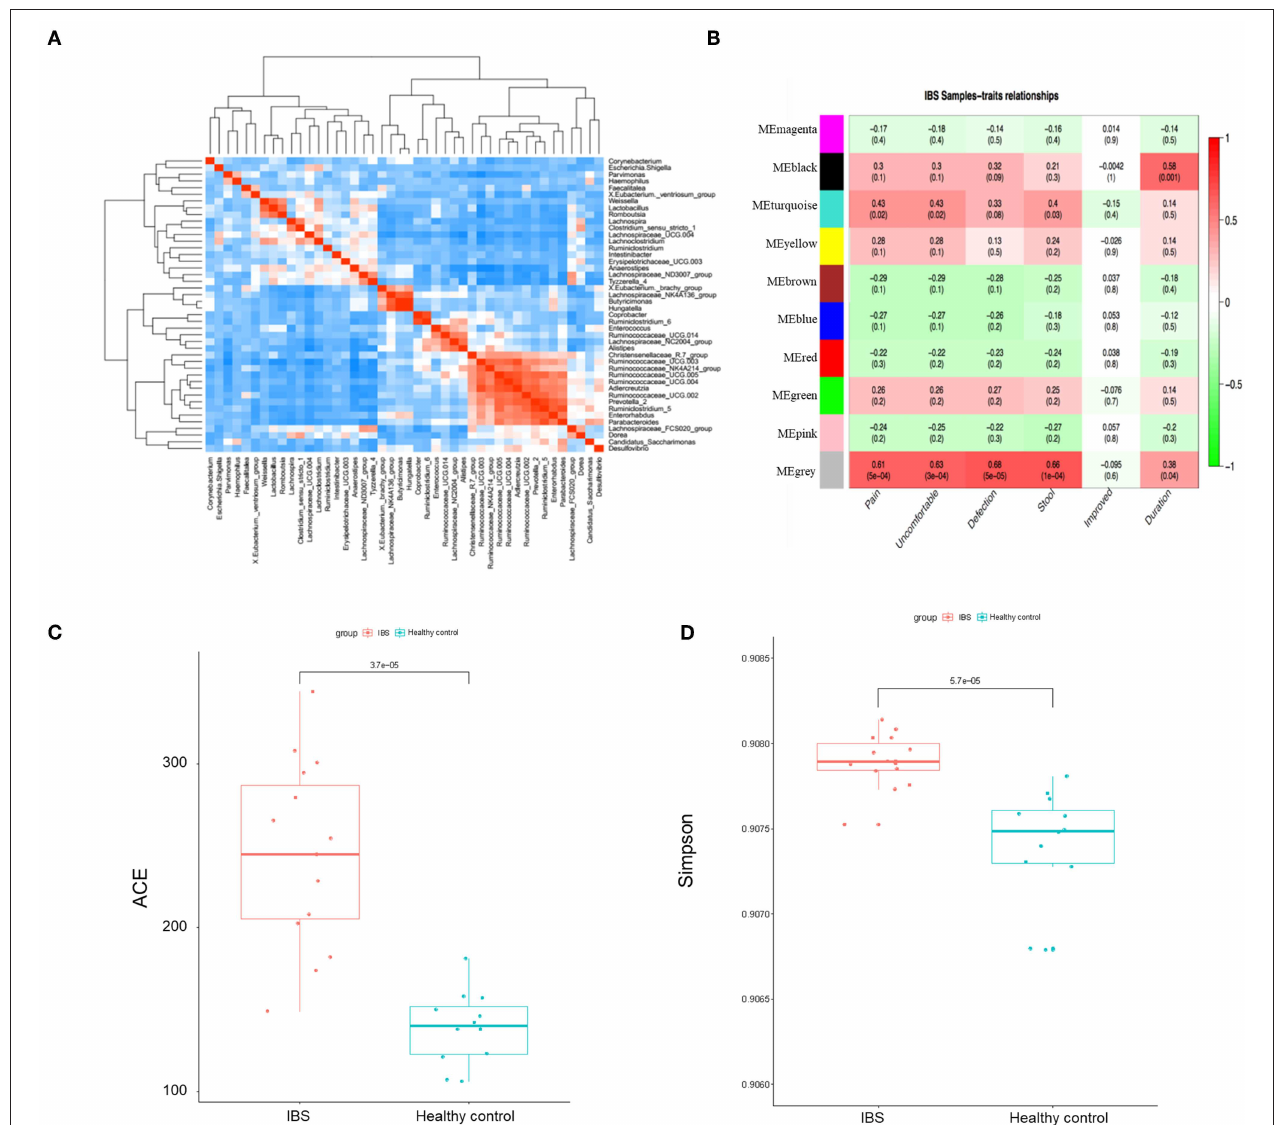
FIGURE 4 | The association between microbial profile and severity of IBS. (A) The correlation matrix showed that some microbes were positively correlated with each other and some were negatively correlated with each other. (B) Module-trait association of microbes. Each row corresponds to a module of microbes, and column corresponds to a clinical trait. Each cell contains the corresponding correlation and P -value. Each table is colored by correlation according to the color legend on the left. Alpha diversity of ace (C) and simpson (D) index of the IBS patients and the healthy